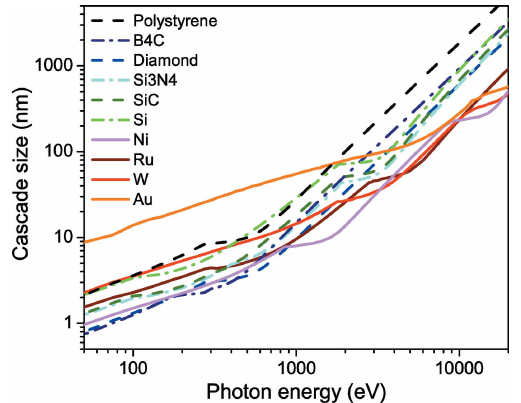
Figure 7 Sizes of the cascades induced by a photon of given energy in different materials. Materials are listed by increase of the average atomic